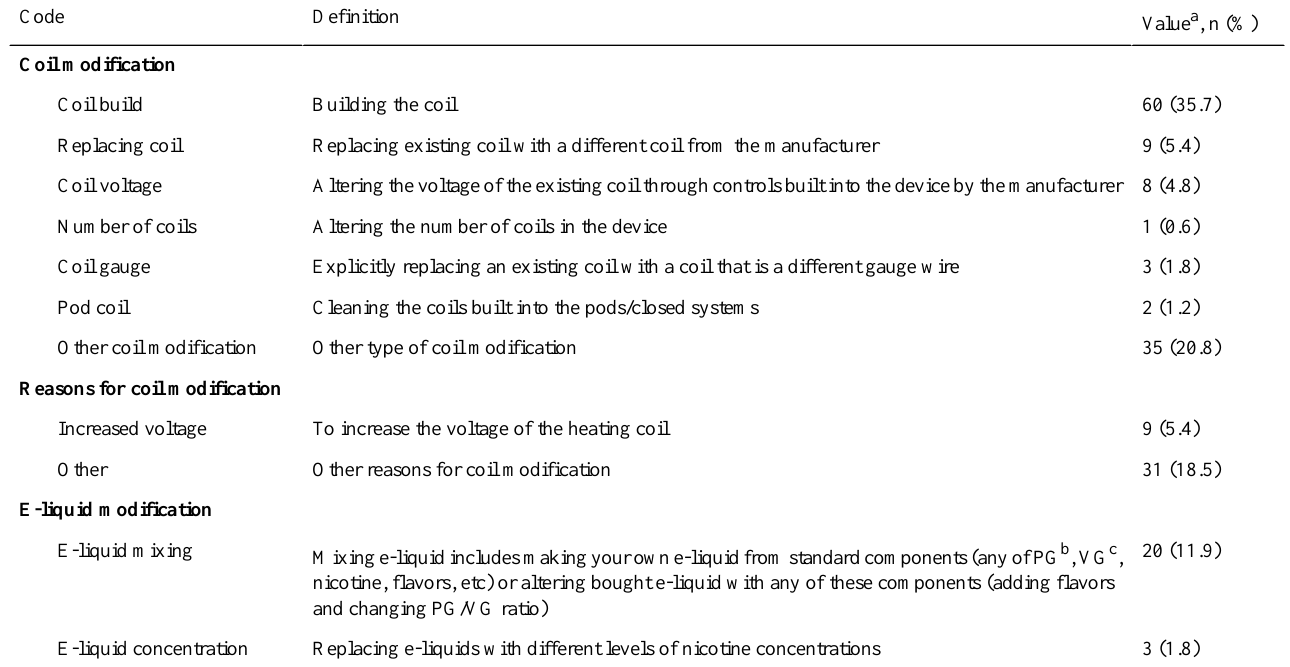
Table 2. Codes and definitions of modifications and reasons for modifications